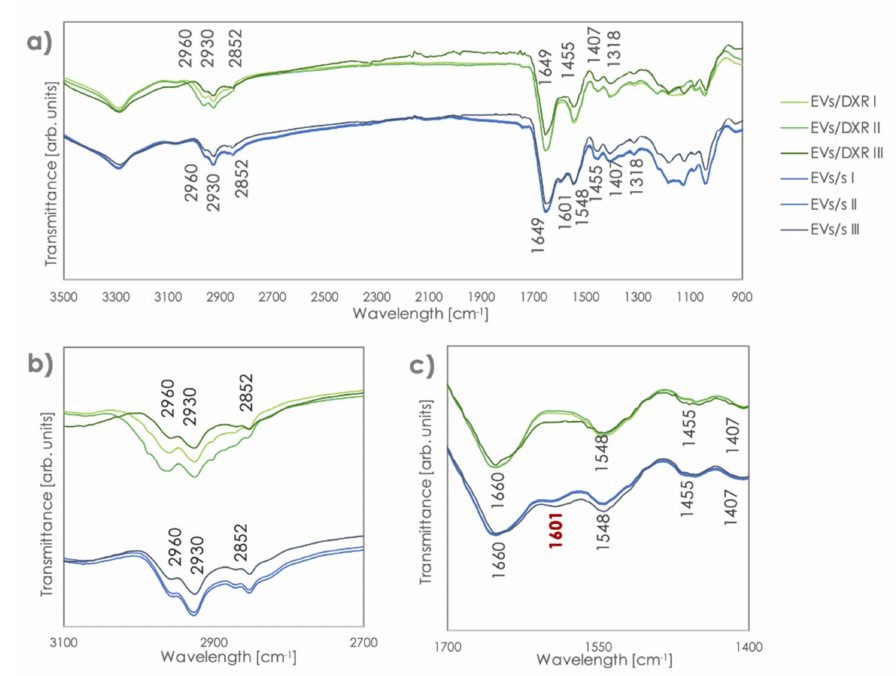
Figure 4. FT–IR/ATR spectra of EVs/s and EVs/DXR. ( a ) Spectra of EVs after scaling with respect to the band at 1649 cm − 1 and zooms on the ( b ) lipid and ( c ) protein areas. The band in red, at 1601 cm − 1 , permits distinction between sensitive and resistant